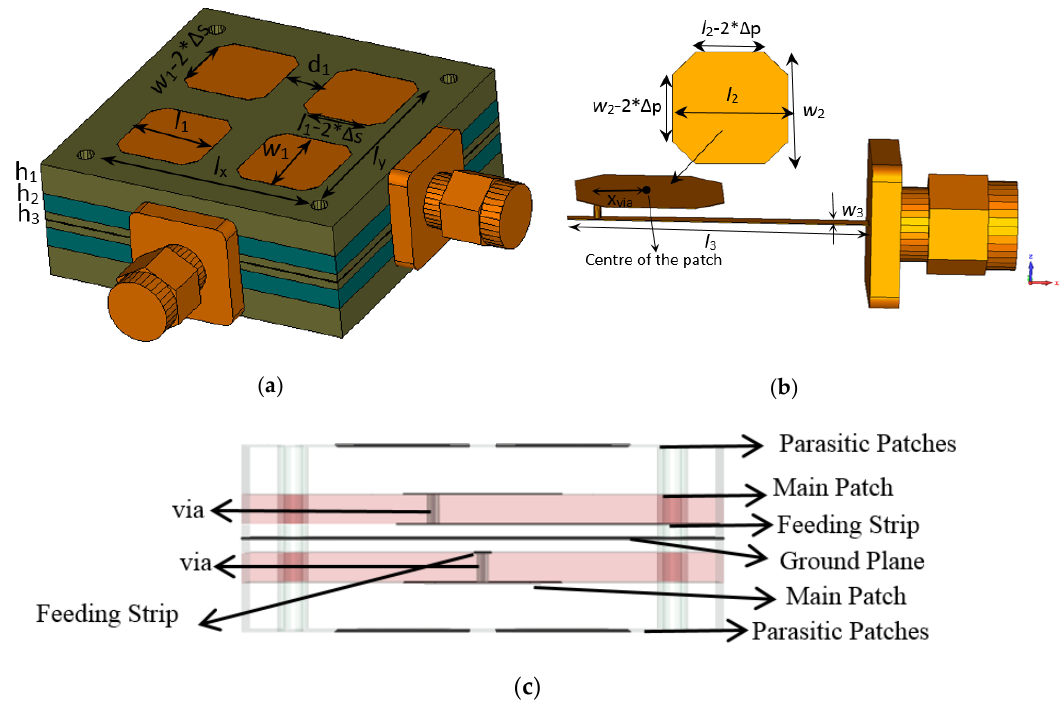
Figure 1. The proposed antenna geometry: ( a ) wideband MIMO antenna dimensions, ( b ) feeding structure and location of the via, and ( c ) side view of the antenna.